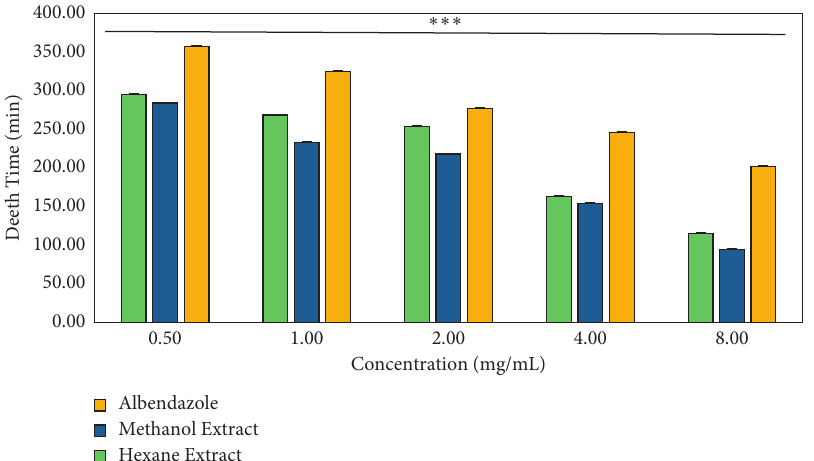
Figure 3: Anthelmintic activity of the extracts of V. camporum and albendazole. Each time represents mean ± SEM ( N � 3); ∗∗∗ P < 0 . 001 compared to the albendazole treatment using one-way ANOVA.